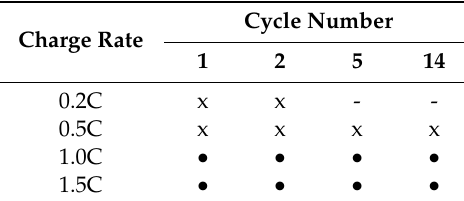
Table 5. Results of stripping discharges at 10 ◦ C, whereby “ • ” stands for detected, “x” for not detected lithium plating and “-” for not investigated.